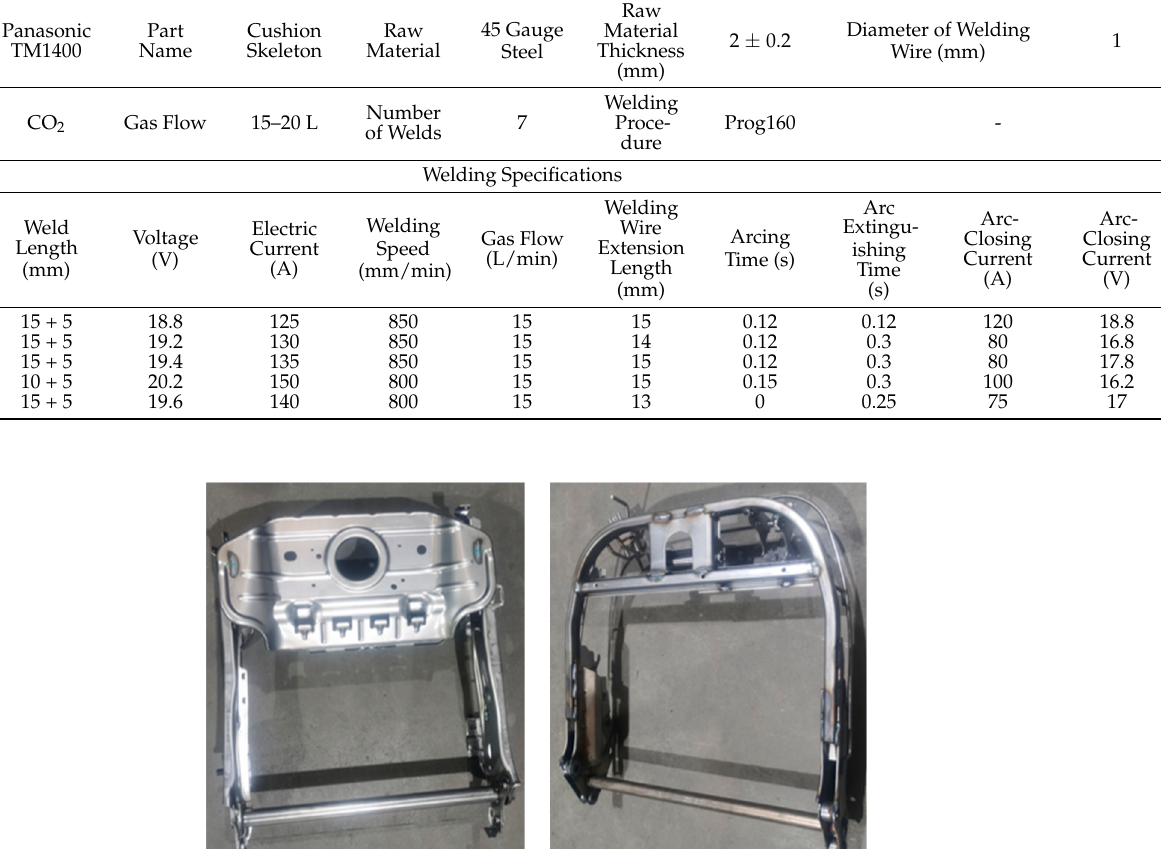
Table 2. Target welding seam parameter table. Arc Welding Robot Welding Parameter Table